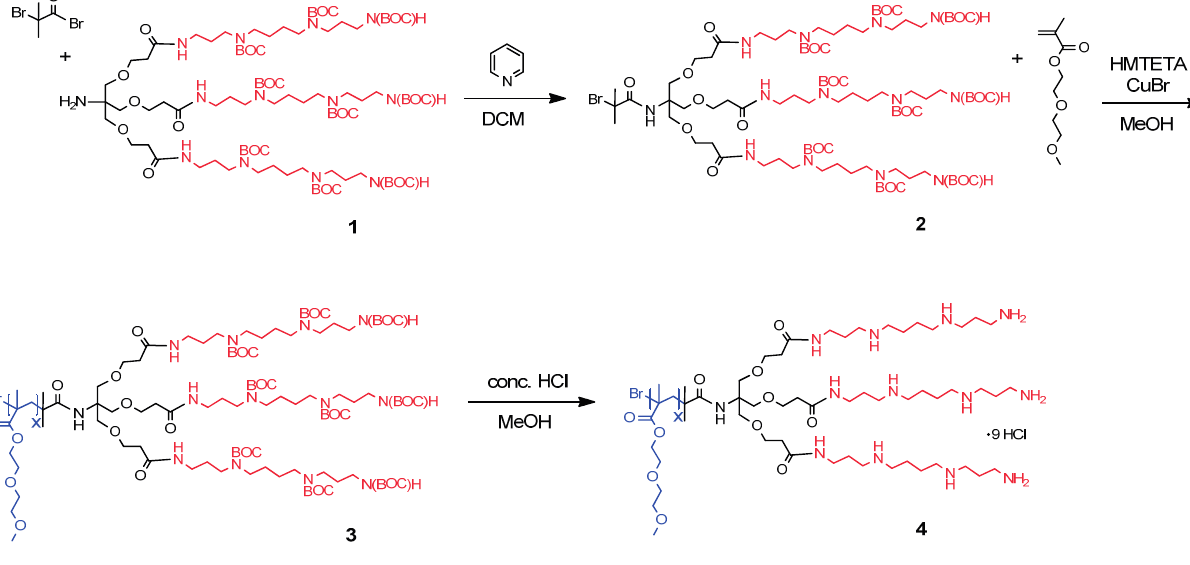
Figure 1. Synthesis of the stimuli-responsive linear-branched diblock copolymer ( 4 ). The branched part consists of a cationic multivalent dendron with a trifurcated Newkome-type frame and spermine ( red ) functionalized surface. The linear thermoresponsive polymer tail (poly(di(ethylene glycol) methyl ether methacrylate)) ( blue ) at the focal point is polymerized in situ using atom-transfer radical